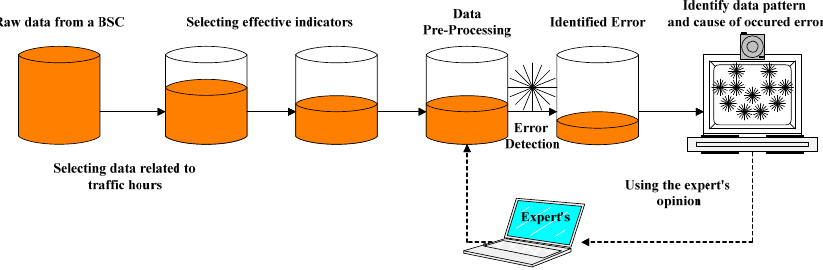
Figure 4. Architecture of the proposed method with performance support system data.